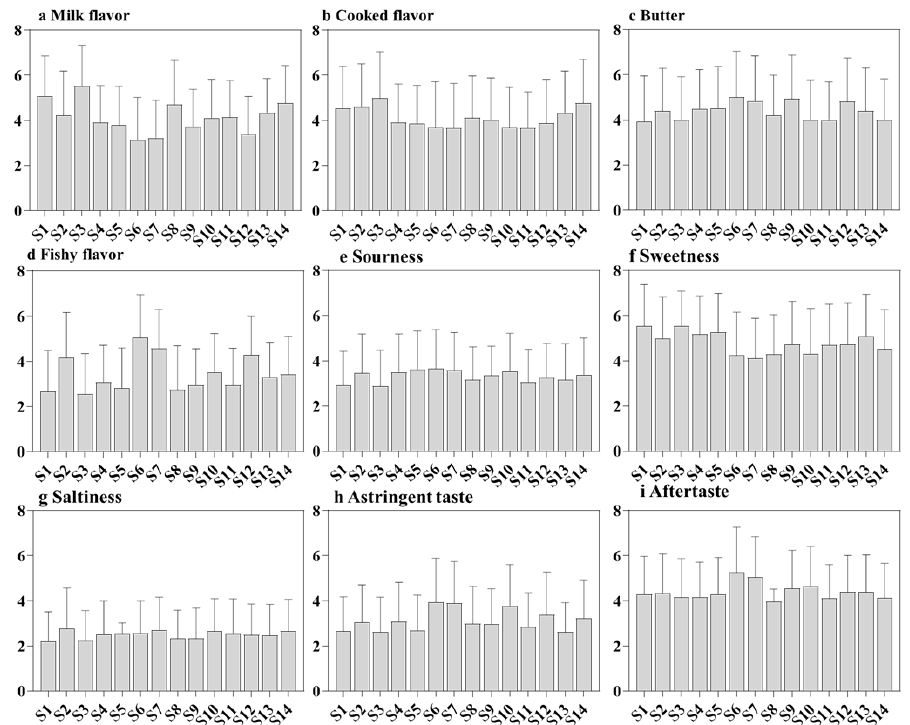
Figure 3. Histogram of odor and taste attributes rating of fourteen milk powder samples (labeled individually from S1 to S14) available in the Chinese market. ( a – d ) Histograms of odor sensory scores. ( e – i ) Histograms of taste scores.